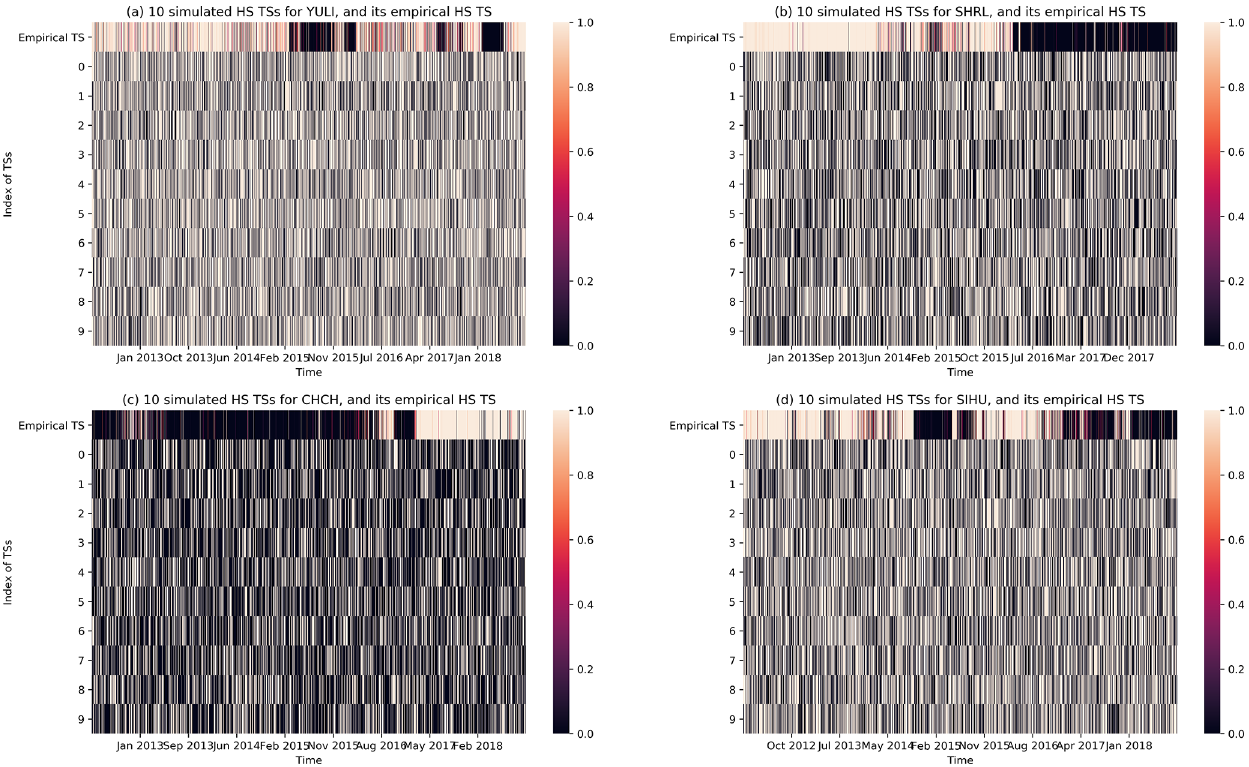
Figure 10. The empirical HS TS and 10 simulated HS TSs, for the stations (a) YULI, (b) SHRL, (c) CHCH, and (d) SIHU. The simulated HS TSs have HS transition frequencies and HS total durations similar to the empirical HS TS but have none of the temporal correlations in the empirical HS TS. Results are obtained using optimal hyperparameters individually specified for each station in Fig.